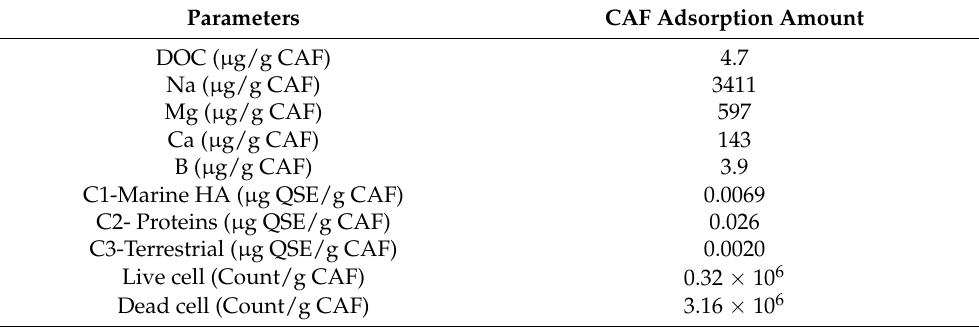
Table 4. Autopsy analysis results for the CAF after the 2nd evaluation